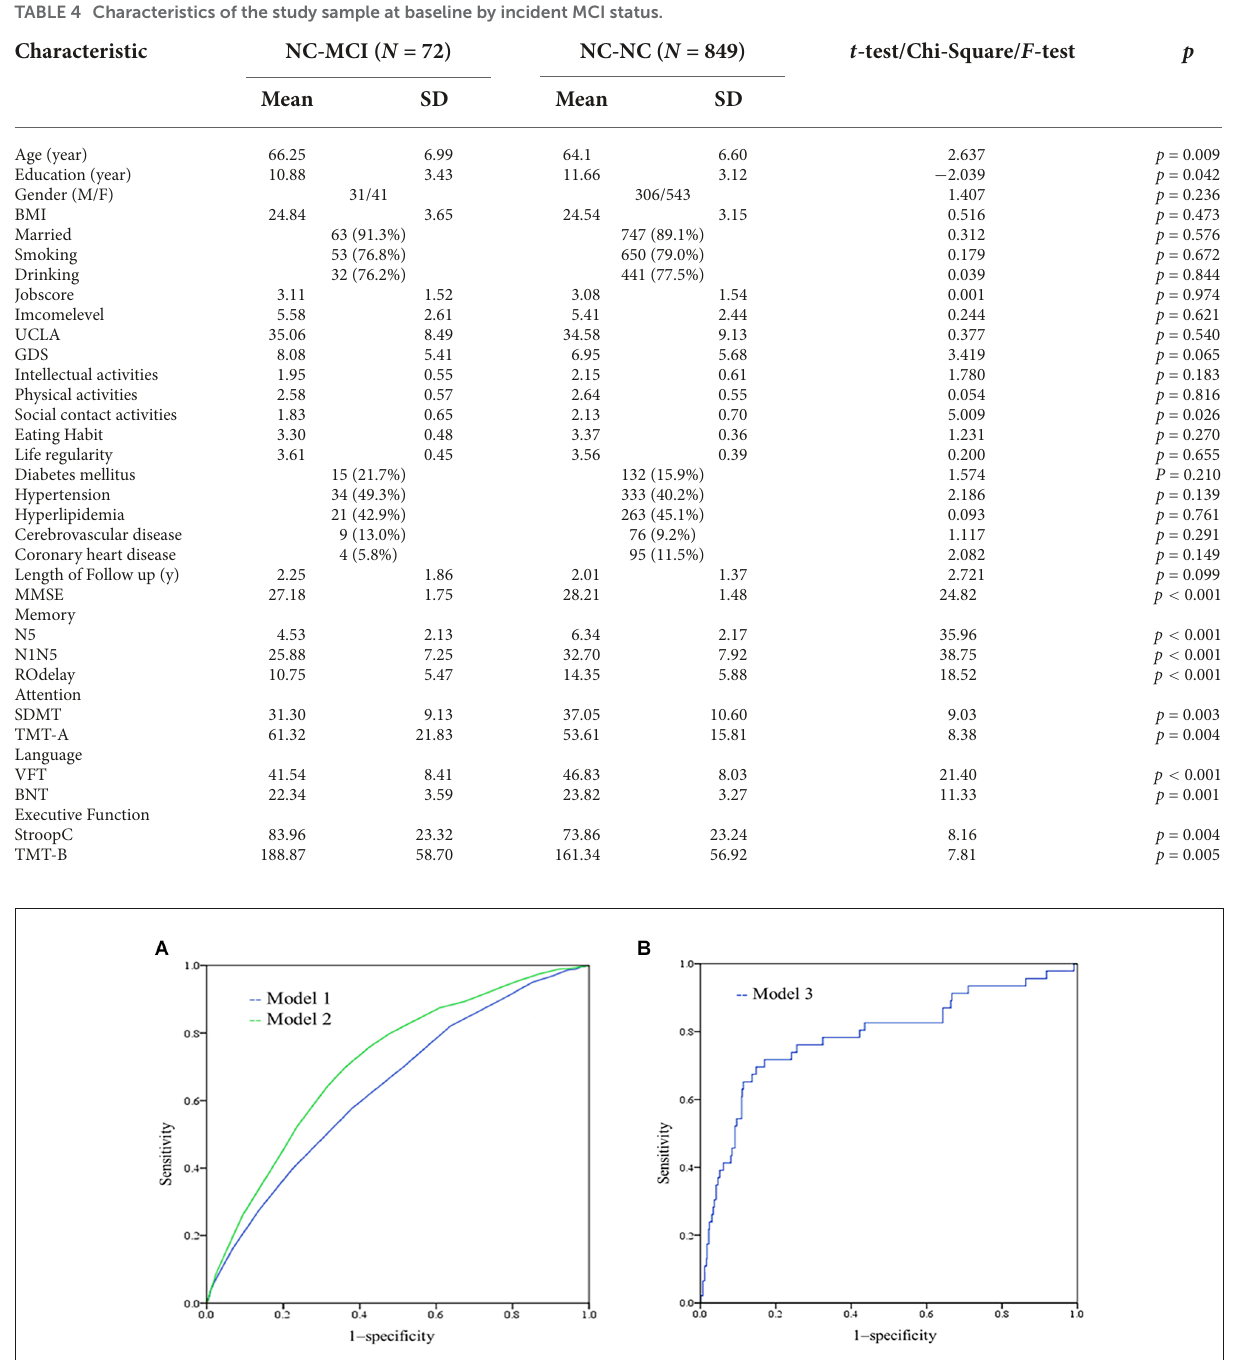
FIGURE1 (A) Receiver-operating characteristic (ROC) of model 1 and model 2. The AUC for model 1 was 0.640 (95% CI 0.620–0.660), and the AUC for model 2 was 0.712 (0.694–0.730); (B) ROC curves showing the performance of the mild cognitive impairment (MCI) risk scores (model 3) in predicting the incident